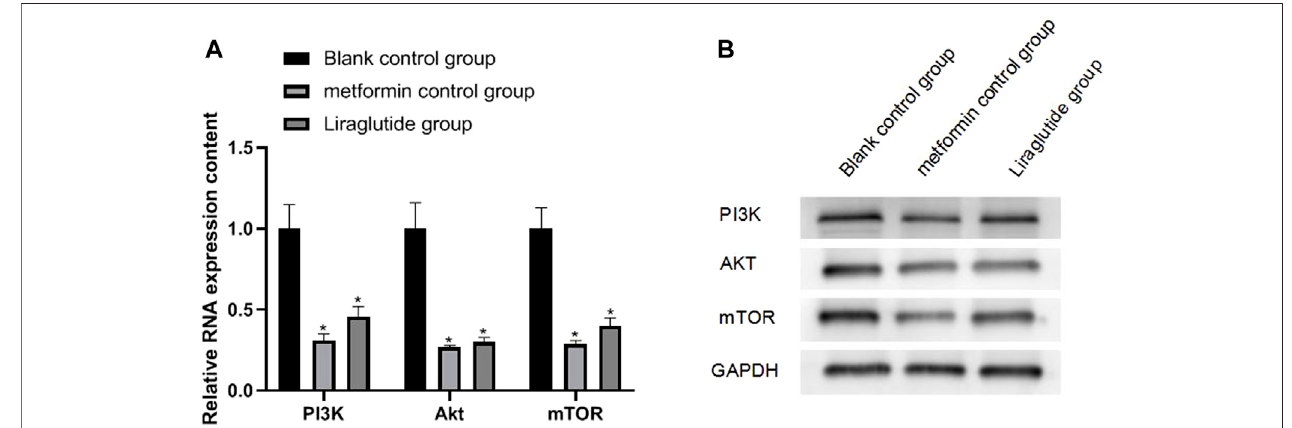
FIGURE 5 | Effects of GLP-1 receptor agonists on the expression of PI3K/Akt/mTOR in CRC cells. Note: (A) qRT-PCR experiment; (B) Western blotting experiment, compared with blank control group, * p < 0.05.